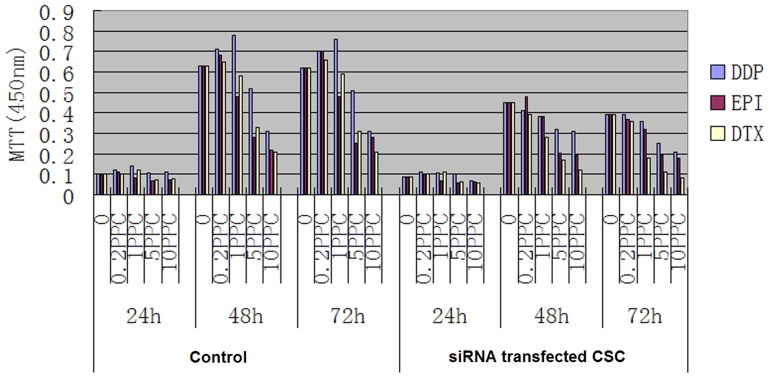
MTT assay shows that the cells exposed to periostin siRNA showed a significant decrease in IC50 among the DDP, EPI, and DTX compared with the control siRNA group (control group) (P<0.01).